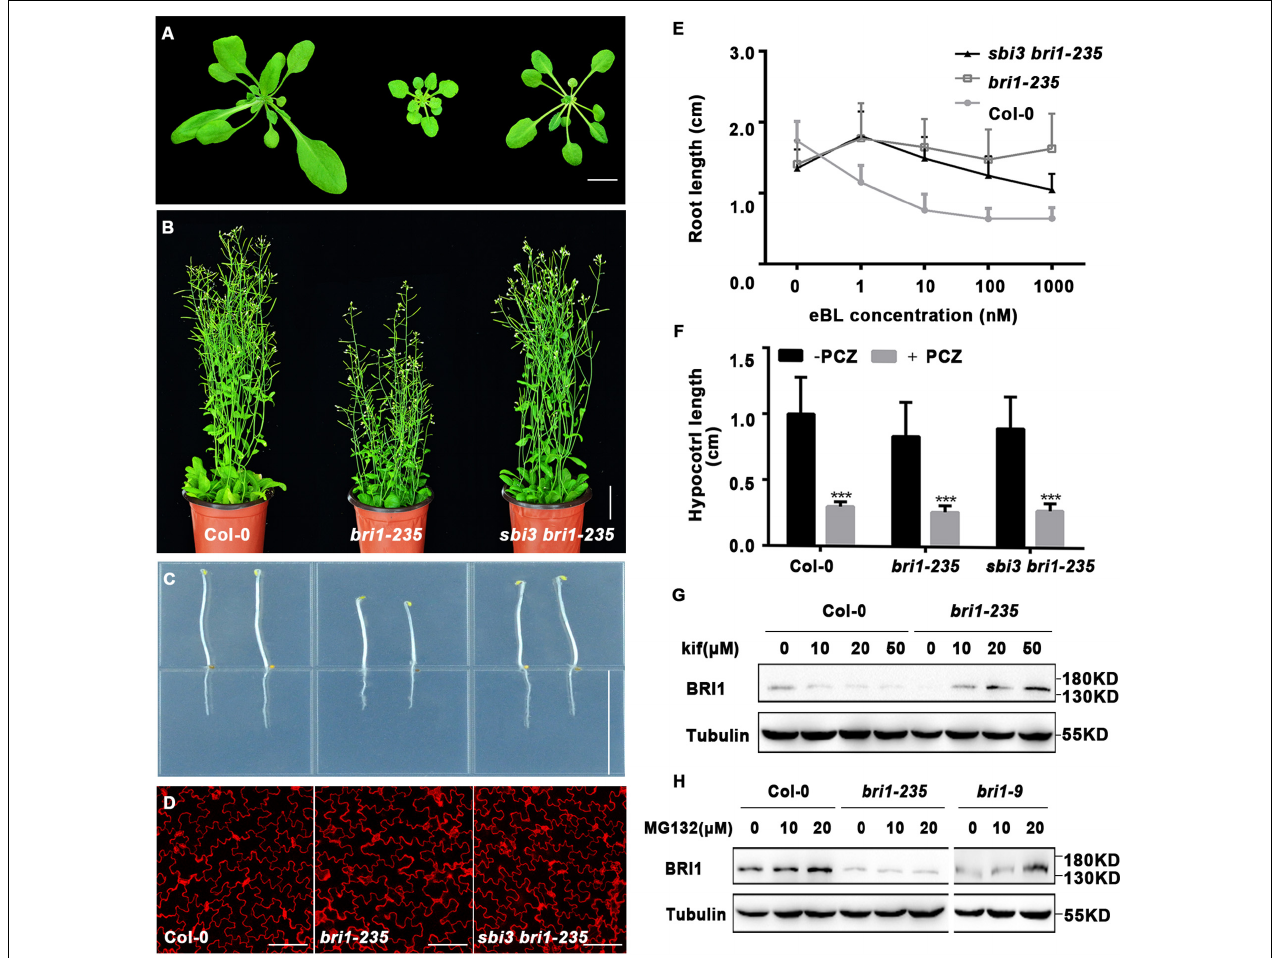
FIGURE 2 | A mutant sbi3 weakly suppresses bri1-235 phenotypes. (A) Phenotypes of two-week-old soil-grown seedlings of Col-0, bri1-235, and sbi3 bri1-235 . Scale bar, 1 cm. (B) Phenotypes of 2-month-old mature plants of Col-0, bri1-235, and sbi3 bri1-235 . Scale bar, 3 cm. (C) Hypocotyl comparison of 5-day-old dark-grown seedlings of Col-0, bri1-235, and sbi3 bri1-235 . Scale bar, 1.5 cm. (D) Morphology of cotyledon pavement cells of 7-day-old seedlings from Col-0, bri1-235 , sbi3 bri1-235 . Scale bar, 100 µ m. (E) The 24-eBL-induced root inhibition assay. Quantitative measurements analysis of root length of 8-day-old Col-0, bri1-235, and sbi3 bri1-235 seedlings were plotted as the line graph and displayed in panel (E) , n ≥ 30 seedlings. Error bar represents ± standard deviation (SD), three independent assays were performed with similar results. (F) Measurements of hypocotyl length of 5-day-old dark-grown in 1/2 MS medium treated with or without 5 µ M PCZ seedlings were plotted as a histogram. *** P < 0.001. (G) Immunoblot analysis of BRI1 abundance in 2-week-old seedlings incubated with or without Kif for 24 h in liquid half-strength MS medium. The protein abundance of BRI1-235 was increased by treatment with Kif. (H) Immunoblot analysis of BRI1 proteins in 2-week-old seedlings of Col-0, bri1-235, and bri1-9 supplemented with or without MG132 for 24 h in liquid half-strength MS